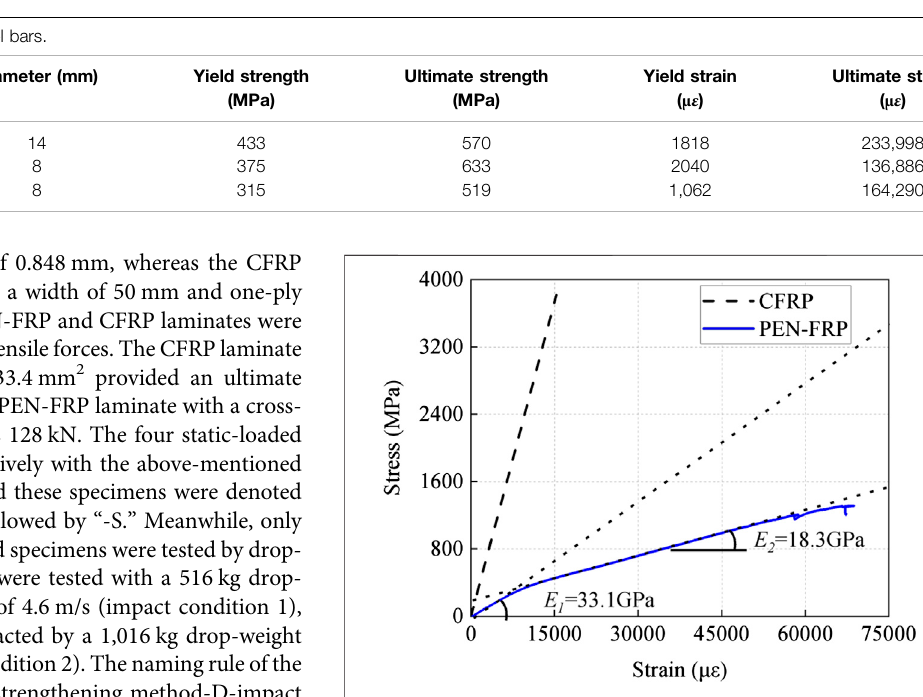
FIGURE 2 | Stress – strain relationships of CFRP and PEN-FRP